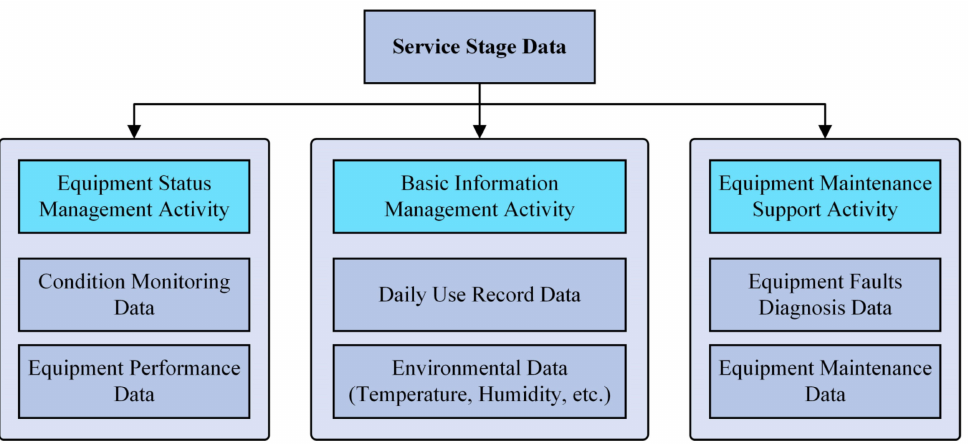
Figure 9. The ILS data collected by sensors in the Service